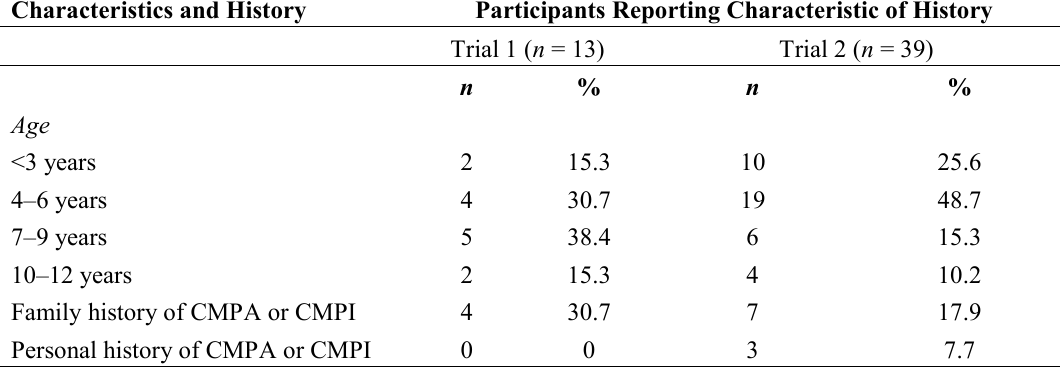
Table 1. Age, family history and clinical history of 13 participants recruited to Trial 1 and 39 participants recruited to Trial